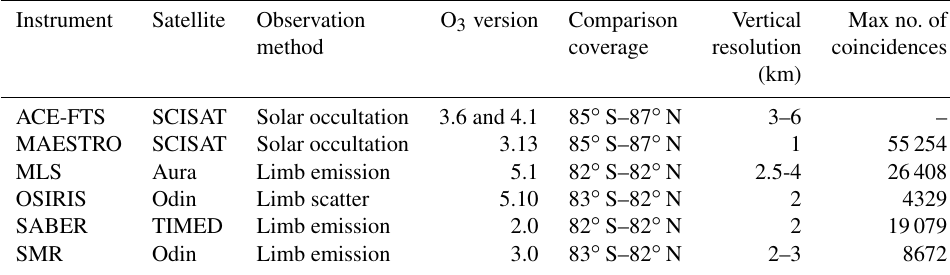
Table 1. Selected details of the instruments and the O 3 data sets used in the comparisons. Instrument Satellite Observation O 3 version Comparison Vertical Max no. of method coverage resolution coincidences (km) ACE-FTS SCISAT Solar occultation 3.6 and 4.1 MAESTRO SCISAT Solar occultation 3.13 MLS Aura Limb emission OSIRIS Odin Limb scatter SABER TIMED Limb